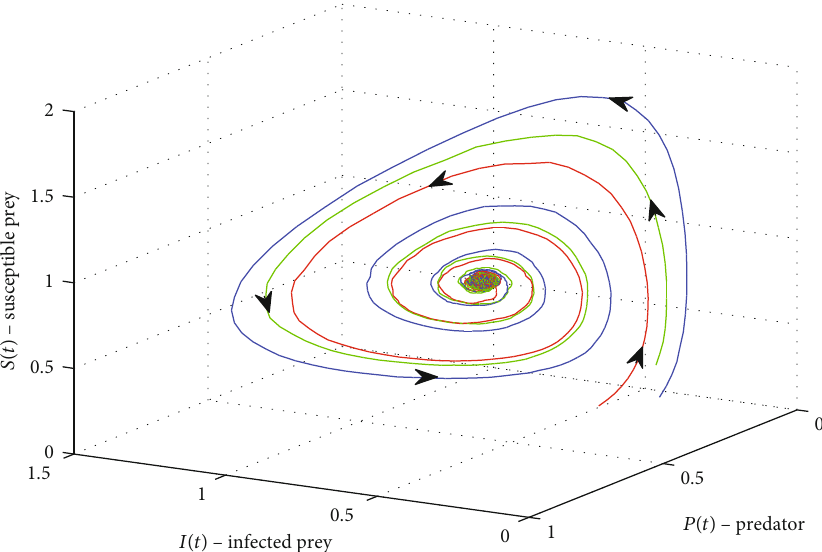
Figure 7: Simulations showing the global stability convergence of the stochastic system (23) around the coexistence equilibrium solution ð S ∗ , I ∗ , P ∗ Þ with di ff erent initial values and σ